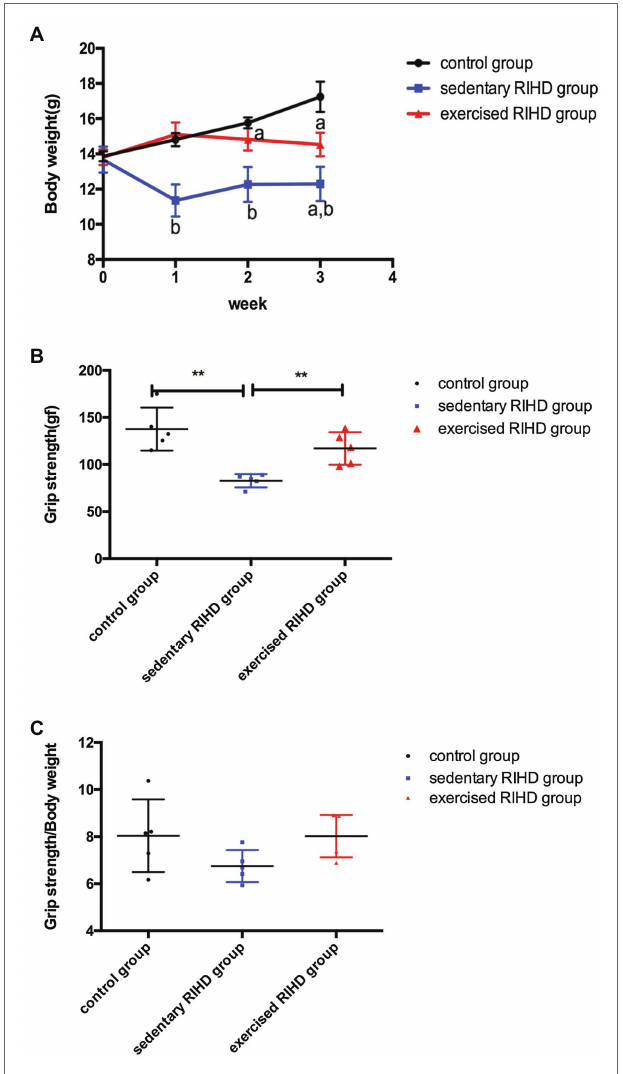
FIGURE 1 | The effect of exercise on body weight and grip strength. (A) Body weights of the control group (black line, n = 5), sedentary RIHD group (blue line, n = 5), and exercised RIHD group (red line, n = 5) at different time points. The results are presented as the mean and standard derivation. p a < 0.05 compared with the control group, p b < 0.05 compared with the sedentary RIHD group. Grip strength (B) and grip strength/body weight (C) at the end of the 3rd week after irradiation were compared by ANOVA. ** p <